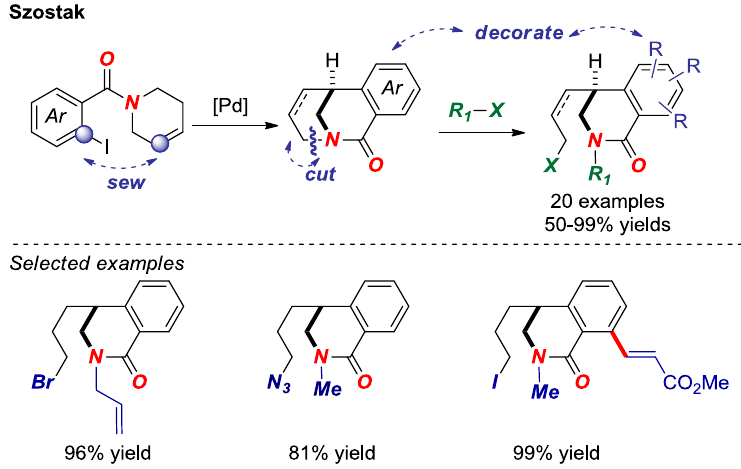
Figure 10. Sew-And-Cut of Bridged Lactams by a Transition-Metal-Free σ N–C Bond Activation.